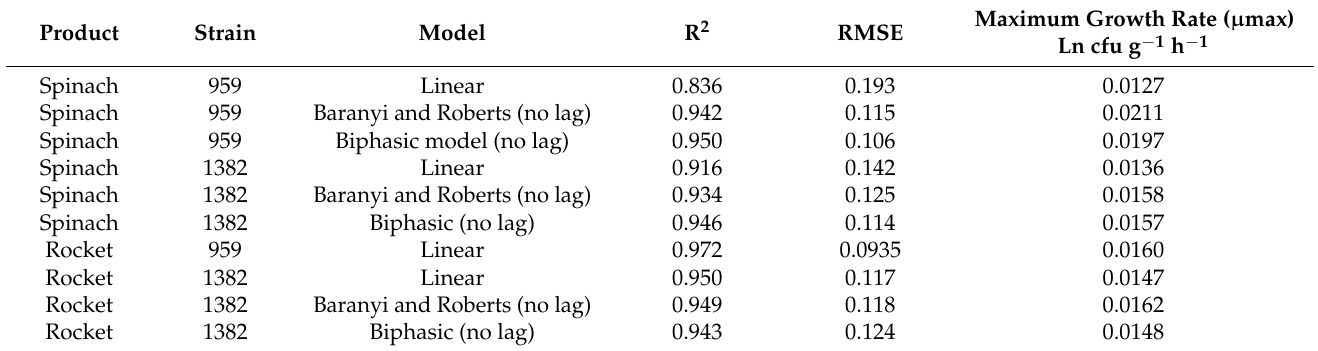
Table 1. Maximum growth rates of L. monocytogenes strains 959 and 1382 on experimental farm Spinach (F1 Trumpet) and Rocket